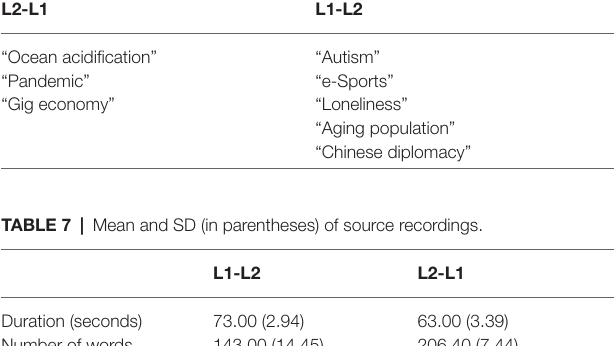
TABLE 8 | Mean and SD (in parentheses) for all measures in CI tasks, with t -tests between